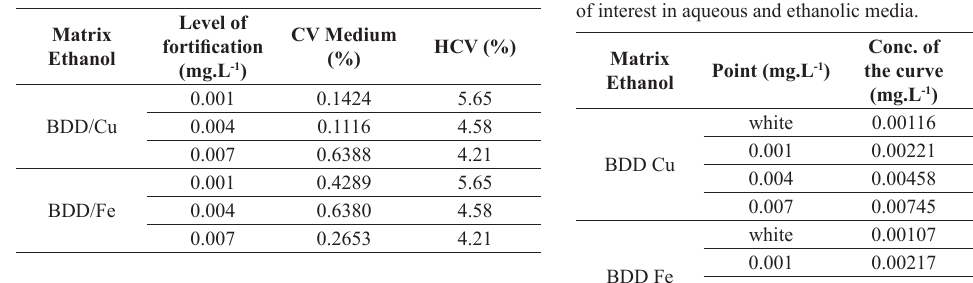
Table 6. Concentrations calculated from low, medium and high concentration control curves and recovery percentages of metals of interest in aqueous and ethanolic media. Matrix H O Point (mg.L -1 ) 2